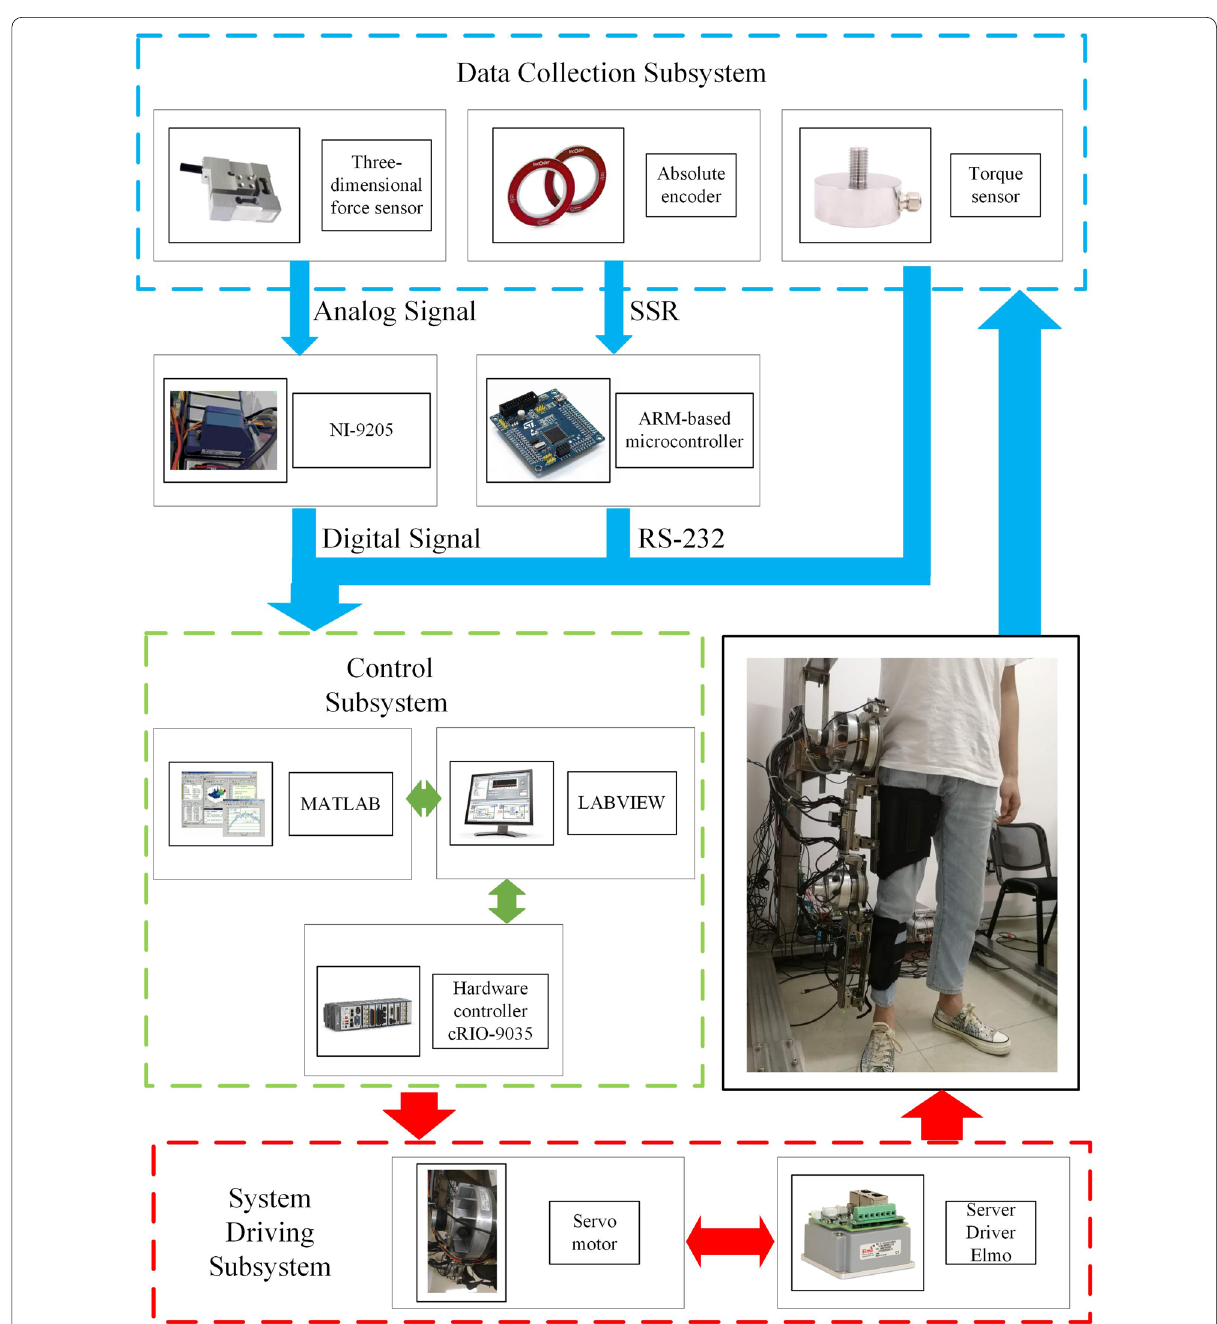
Figure 3 Electronic system of 2-DOF lower limb exoskeleton